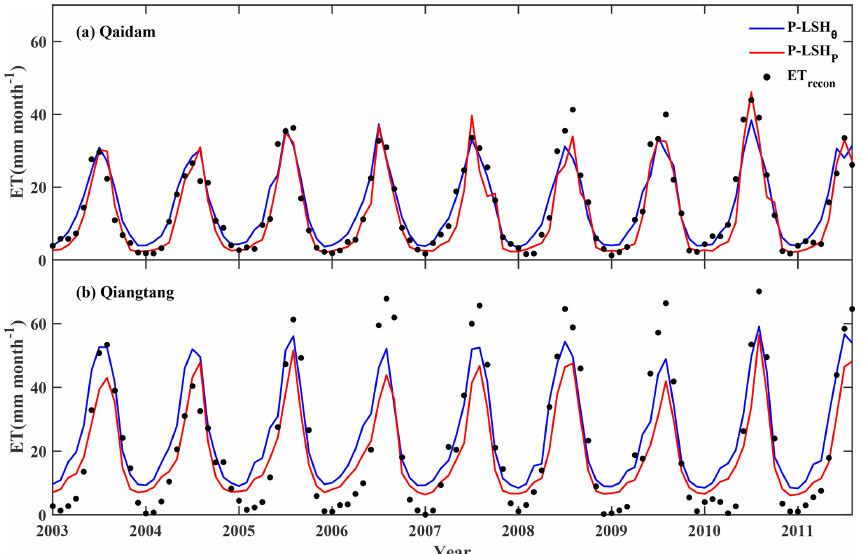
Figure 6. Comparisons of the monthly regional average ET estimates derived from two improved retrieval algorithms (P-LSH θ and P-LSH P ) with the ET recon for (a) the Qaidam Basin and (b) the Qiangtang Plateau.